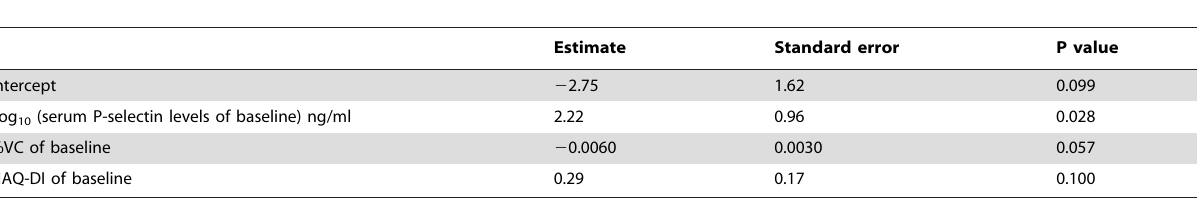
Table 6. Factors predicting HAQ-DI of 4 year follow-up determined by multiple regression